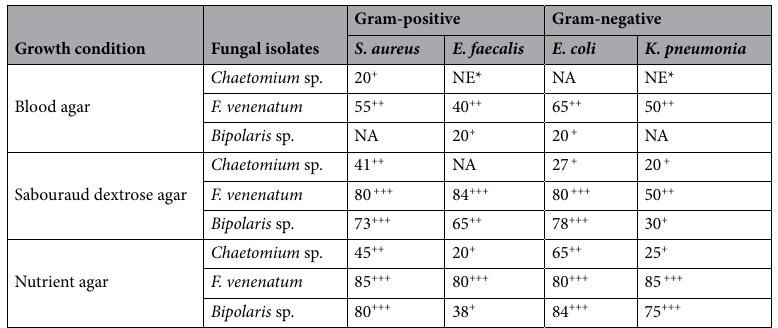
Table 1. Antimicrobial activity screening of fungi from desert soil. Inhibition Zone, 90–70 mm ( +++ , strong inhibition), 69–40 mm ( ++ , moderate inhibition), 39 –20 mm ( + , weak inhibition), and less than 15 mm (NA) (−, no activity) and *No effect